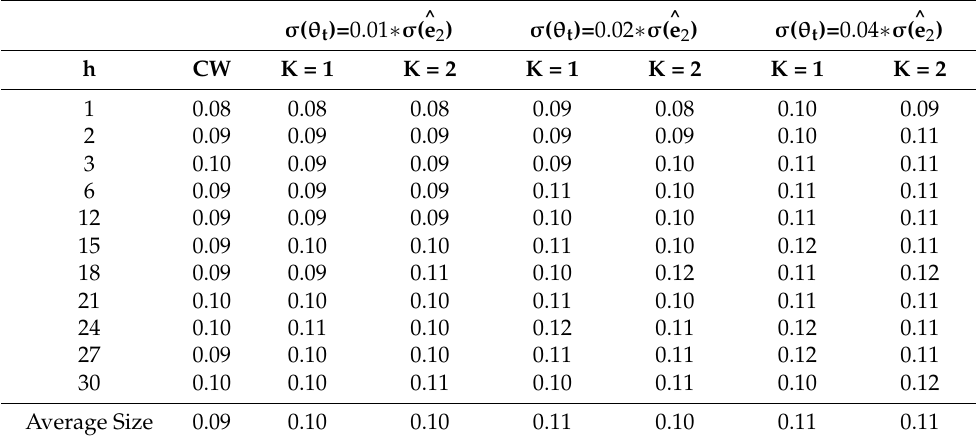
Table 2. Empirical size comparisons between CW and WCW tests with nominal size of 10%, consid- ering DGP1 and a small